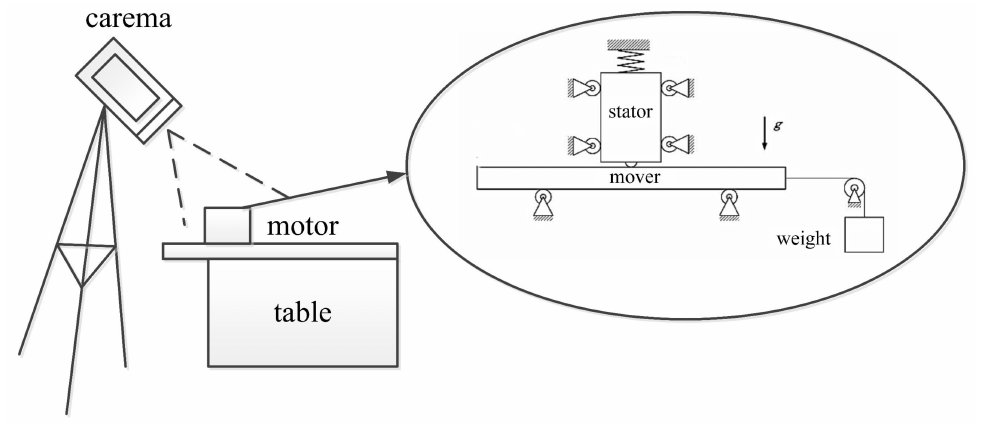
Figure 16. Measuring system.